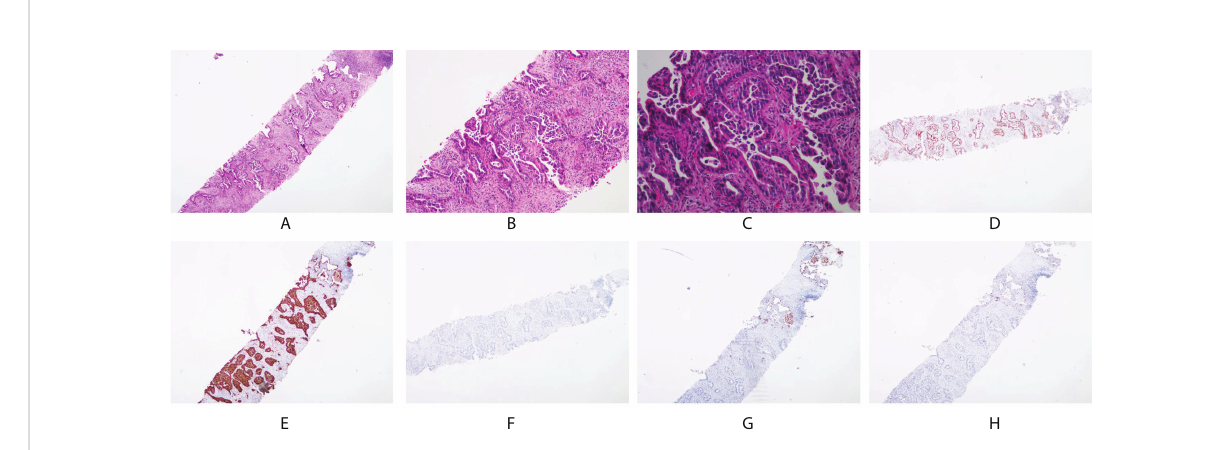
FIGURE 2 Pathological and immunohistochemical examination results. (A) hematoxylin-eosin staining (HE), magni fi cation×40; (B) HE, magni fi cation×100; (C) HE, magni fi cation×200; (D) CDX-2 positivity, magni fi cation×40; (E) CK7 positivity, magni fi cation×40; (F) CK20 negativity, magni fi cation×40;